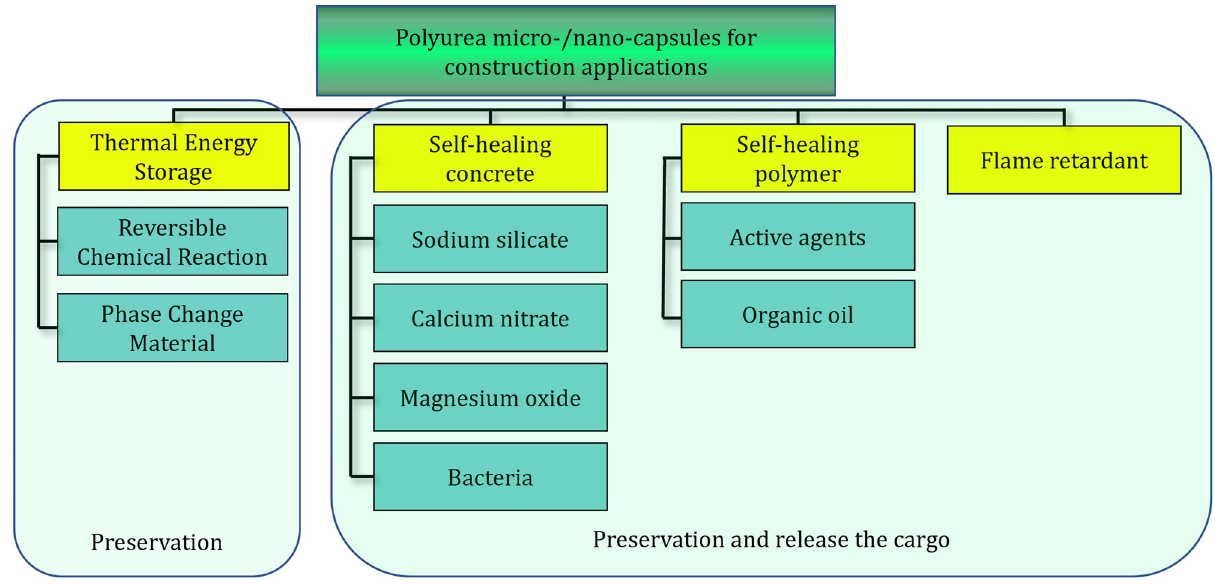
Figure 7: Summary of applications of polyurea micro - /nano - capsule in the construction